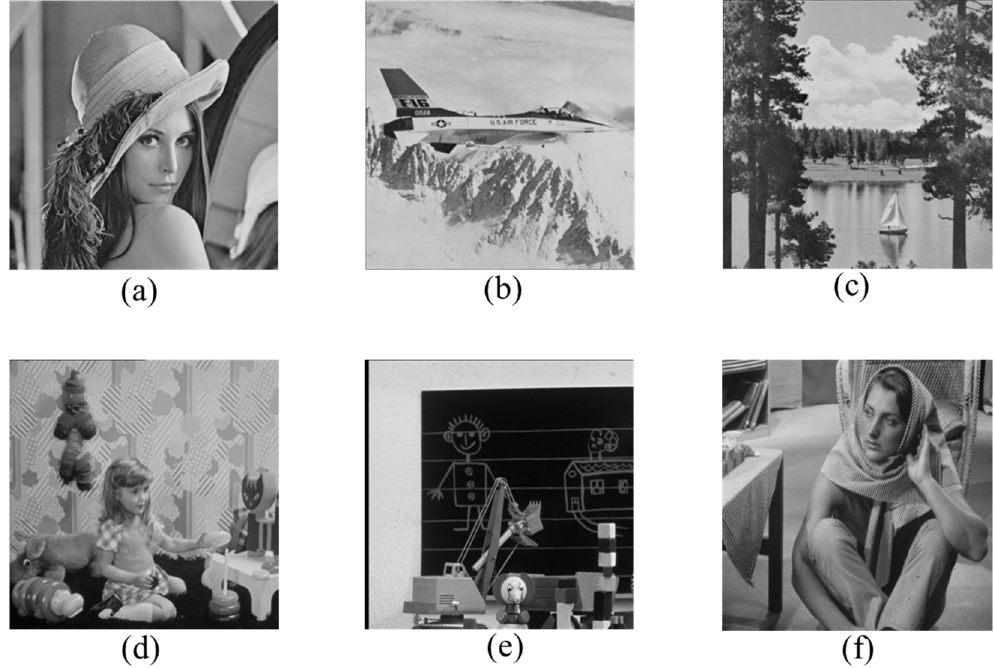
Figure 8. Test images ( a ) Lena; ( b ) F-16; ( c ) Sailboat; ( d ) Girl; ( e ) Toys; ( f ) Barbara.